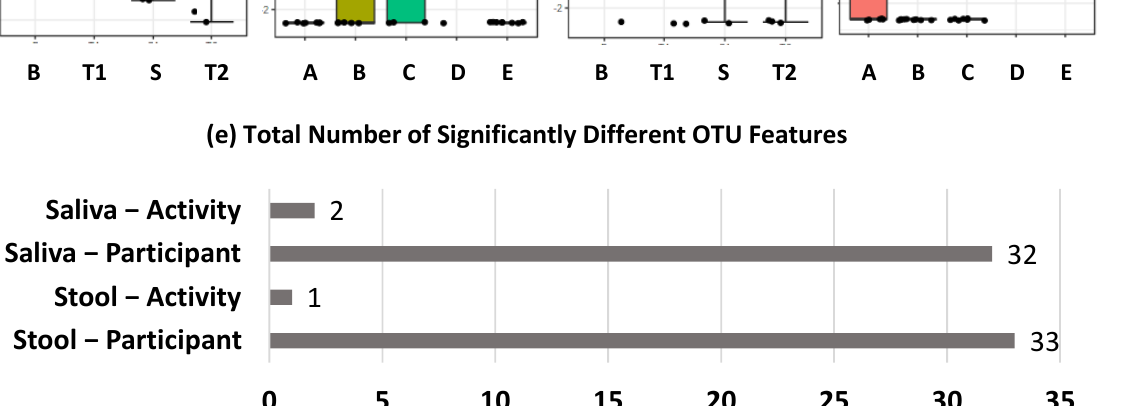
Figure 2. Metataxonomic fingerprinting shows spatially distinct effect of TAWT journey. ( a – d ) PCoA